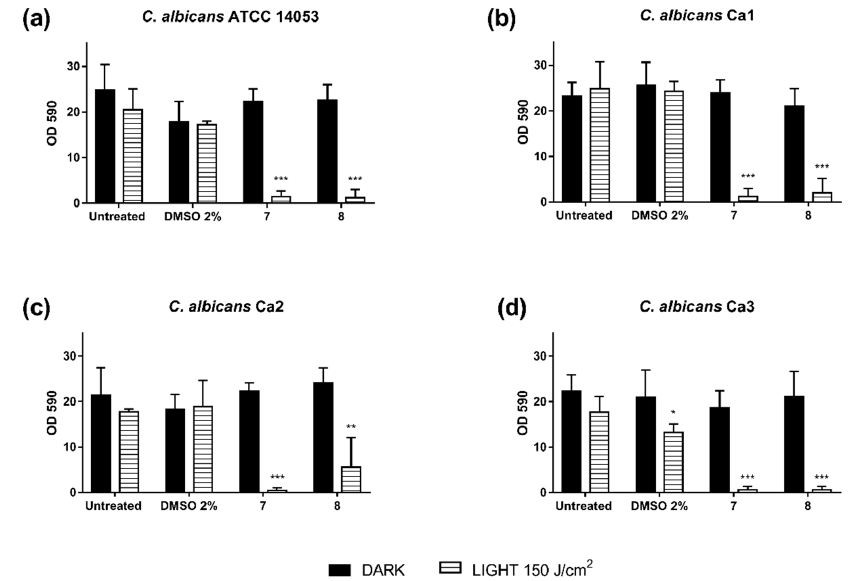
Figure 8. Inhibition of biofilm formation of four Candida albicans strains, ATCC 14,053 ( a ), Ca1 ( b ), Ca2 ( c ), and Ca3 ( d ), by photodynamic inactivation with Porphyrins 7 and 8 . Porphyrins were activated by 410 nm blue light, 100 mW/cm 2 for 25 min, corresponding to 150 J/cm 2 . The graphs report values of the absorbance at 590 nm (OD 590) of biofilm staining with crystal violet. Dark control samples are presented as black bars and light-treated samples as striped bars. Data represent the mean of at least three independent experiments ± the standard deviation. Statistical analyses were performed by one way ANOVA (* p < 0.05; ** p < 0.01; *** p < 0.0001). Table 2. Inhibition of the biofilm formation of four Candida albicans strains (ATCC 14053, Ca1, Ca2, and Ca3) by photodynamic inactivation with Porphyrins 7 and 8 . Porphyrins were activated by 410 nm blue light, 100 mW/cm 2 for 25 min, corresponding to 150 J/cm 2 . The table reports the results of the viable count of yeast cells belonging to adherent (cfu/well) and planktonic (cfu/mL) populations of the biofilm. Data are presented as the mean of three independent experiments ± the standard deviation. Statistical analyses were performed by one way ANOVA (* p < 0.05; ** p < 0.01; *** p < 0.0001). Adherent biomass (cfu/well)